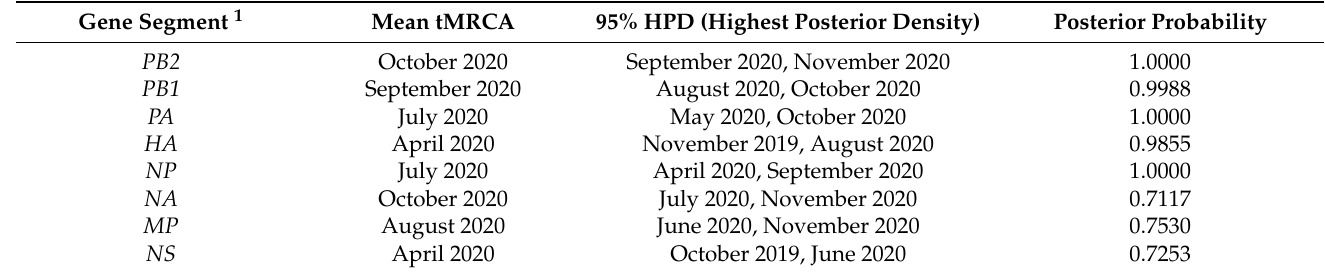
Table 1. The mean time of the most recent common ancestor (tMRCA) for the eight genetic segments of H5N8 AIV from common cranes wintering in Yunnan Province, China, in